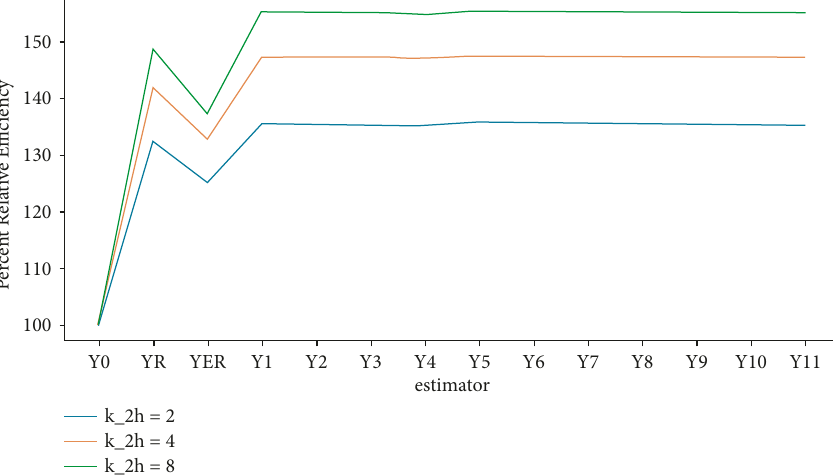
Figure 7: Plot of PREs at 30% nonresponse and 0.2 sensitivity level for population